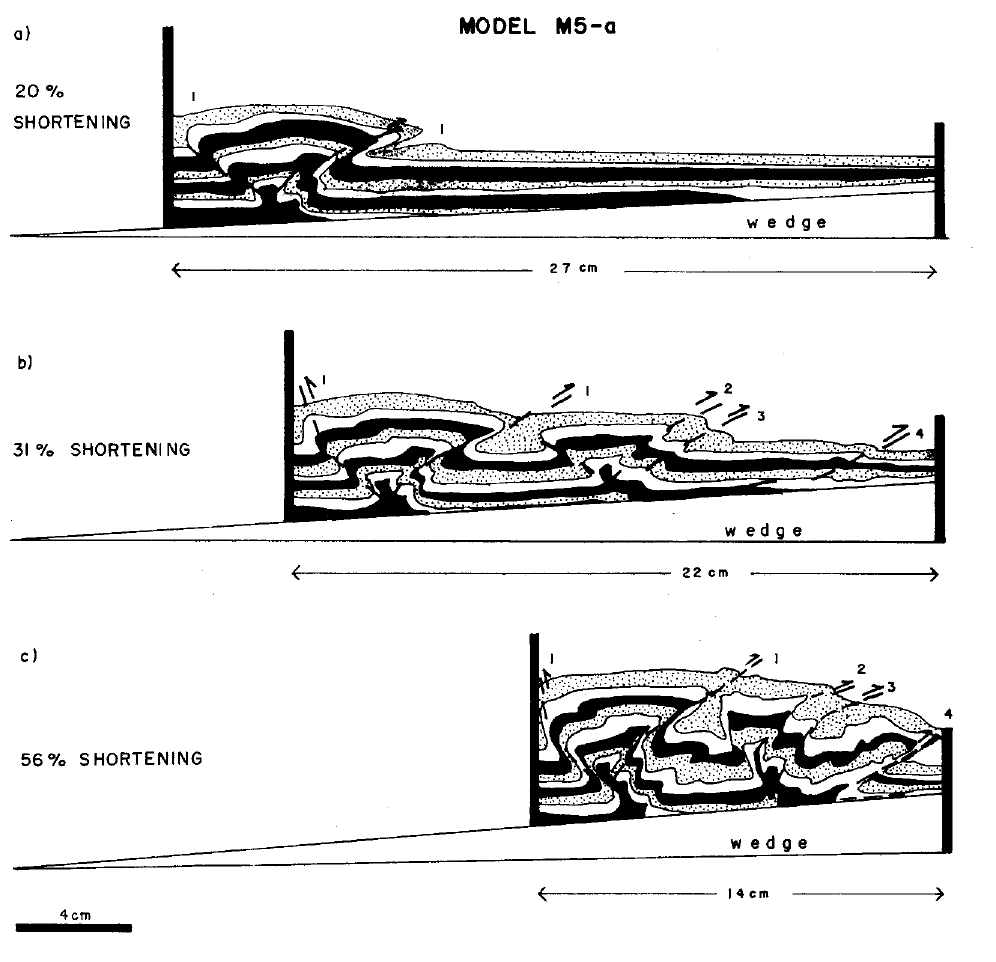
Fig. 14 – Model M5-a with a 5 ◦ inclined basal wedge in the foreland and a rigid backstop. (a) After 20% shortening; (b) after 31% shortening, a duplex system consisting of independent ramp anticlines is formed; and (c) after 56% shortening, the youngest independent ramp anticline has become an antiformal stack.